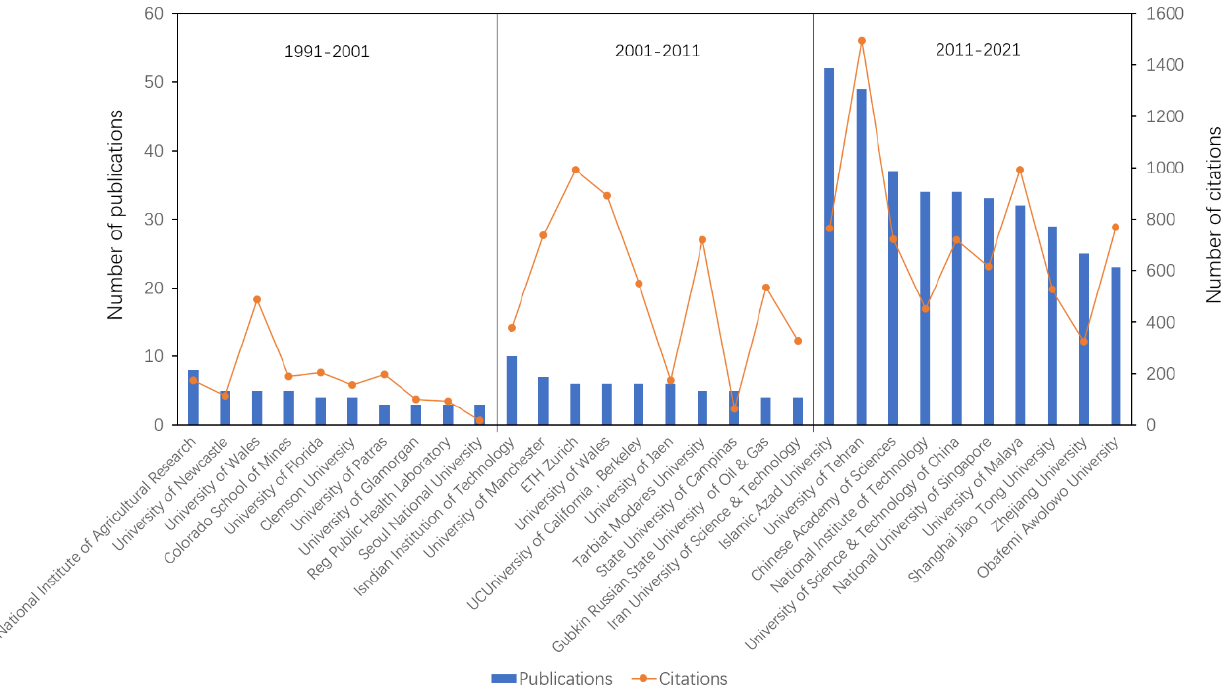
Figure 6. The most accomplished institutions in relation to the number of publications and citations in AI in bioenergy research between the years of 1991 – 2021.